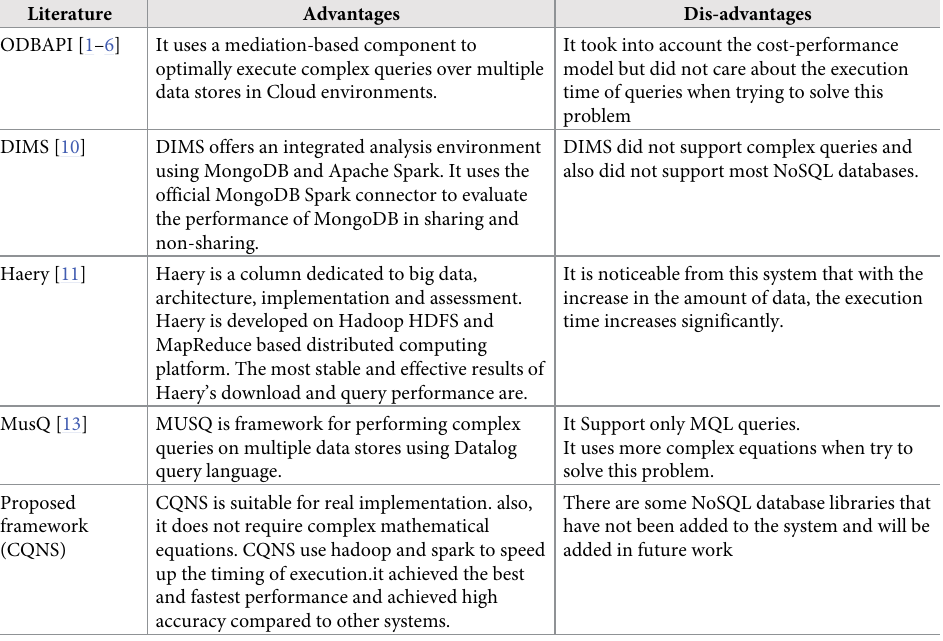
Table 1. The advantages and disadvantages of the proposed framework and the most recent